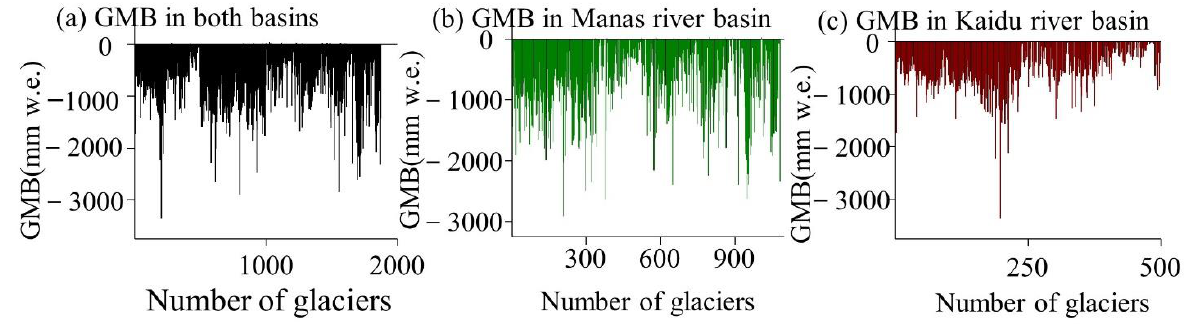
Figure 4. The mass balance of a single glacier in both basins of the central Tianshan Mountains. ( a ) GMB in both basins; ( b ) GMB in Manas river basin; ( c ) GMB in Kaidu river basin.